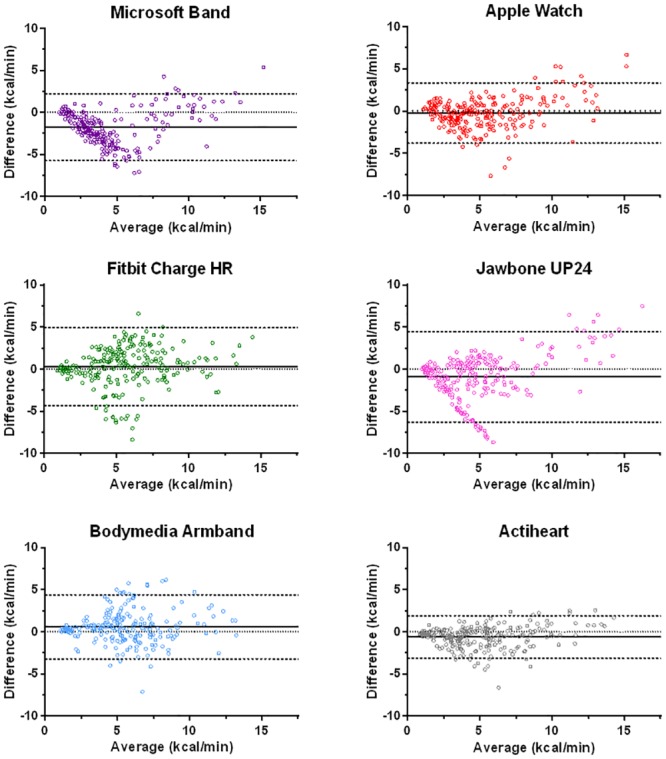
Bland-Altman plots for laboratory activities.Bland-Altman plots depicting absolute bias and 95% limits of agreement of estimated energy expenditure across a number of different activities for a range of activity trackers relative to the criterion indirect calorimetry measure. Bias represents predicted expenditure-criterion expenditure. The solid line represents mean bias, the dashed lines the upper and lower 95% limits of agreement and the dotted line represents perfect agreement.